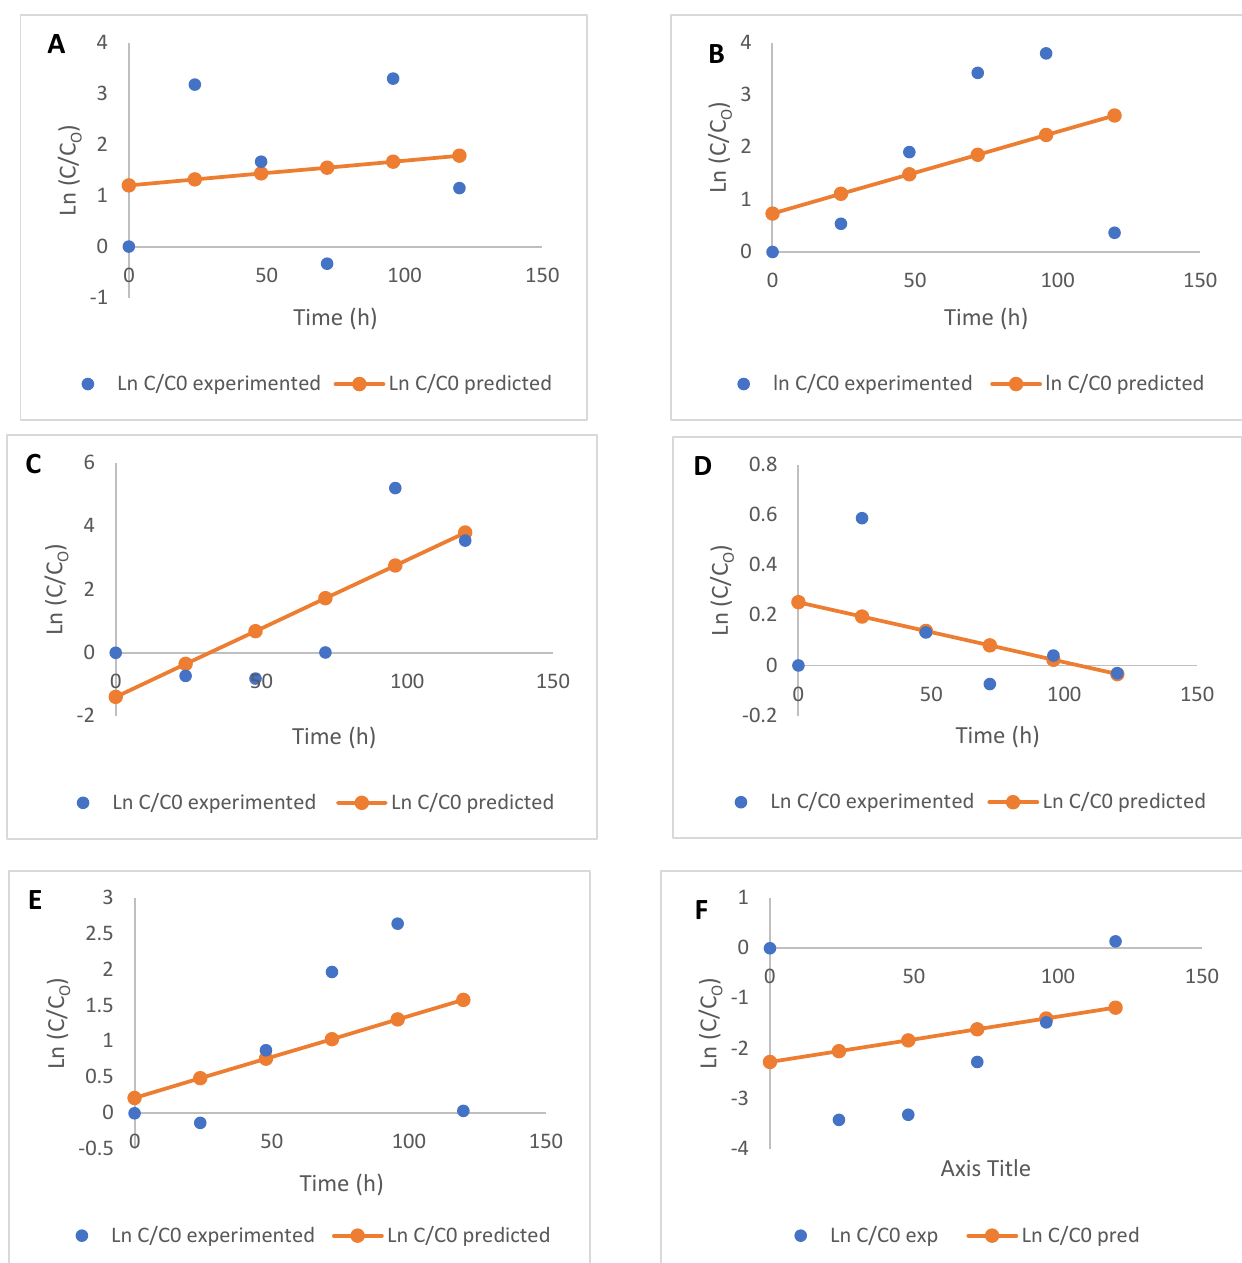
Figure 6. Kinetics (first-order) of bound phenolic acid degradation during the fermentation of maize flour ( A ) caffeic acid, ( B ) ferulic acid, ( C ) gallic acid, ( D ) p -coumaric acid, ( E ) sinapic acid, and ( F ) vanillic acid.